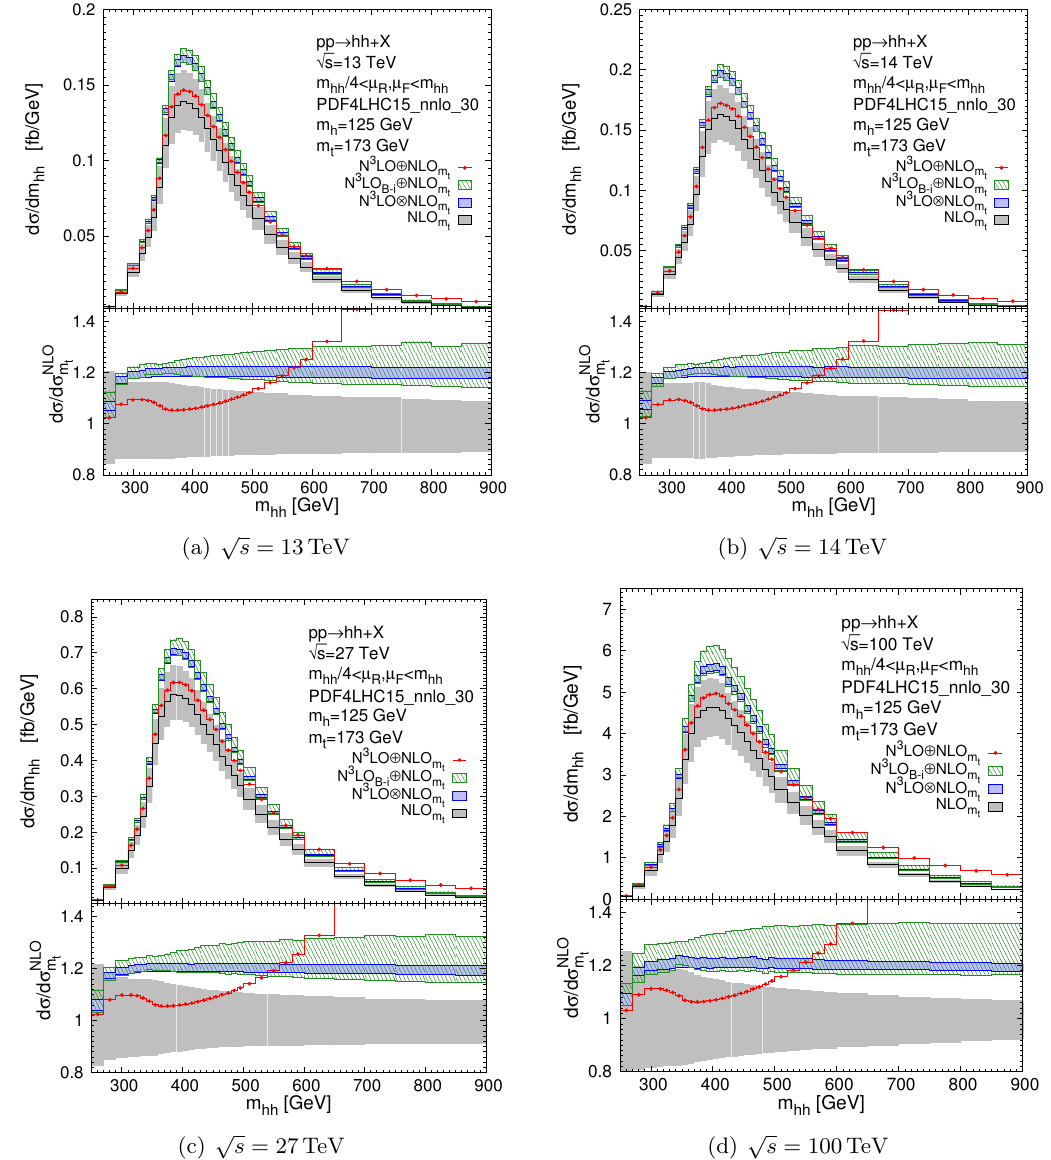
Figure 15 . Invariant mass distributions of the Higgs boson pair under three top-quark mass p approximations at s = 13 ; 14 ; 27 ; 100 TeV. The bands represent the scale uncertainties. The red, green, blue and black curves are the N 3 LO (cid:8) NLO m NLO m predictions, respectively. The bottom panel shows the ratios to the NLO m t